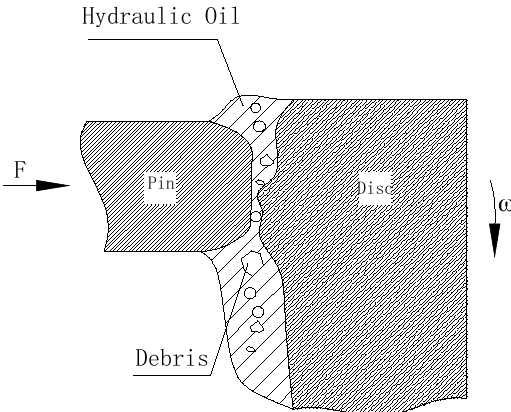
Figure 12. Schematic diagram of the lubrication and wear process.